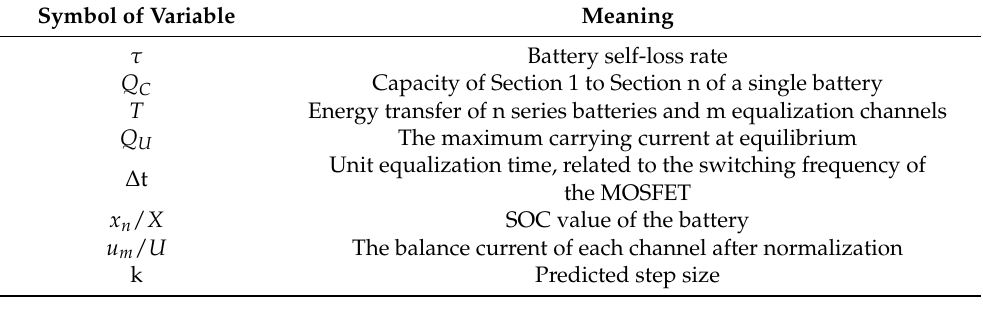
Table 1. Variable